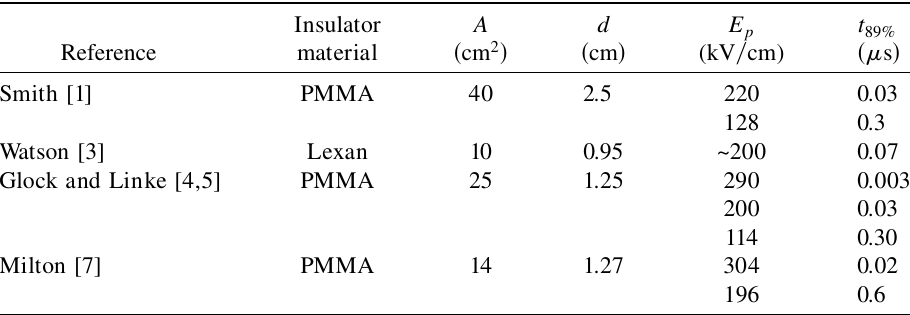
TABLE III. The 45 (cid:1) -insulator-flashover data (as presented in Refs. [6,29]) that were used to develop the JCM flashover relation. As discussed in Appendix A, only two of these measurements [7] were performed with an uncoated 45 (cid:1) PMMA insulator between flat uncoated electrodes, at a pressure (cid:12) 10 (cid:2) 4 torr